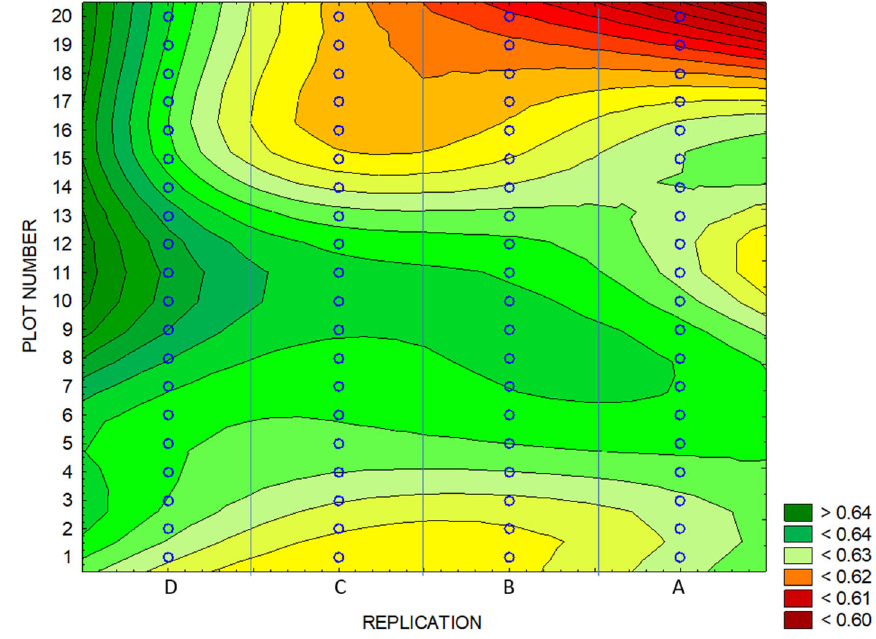
Figure 14. Contour map of NDVI. Blue circles illustrate plot centers.